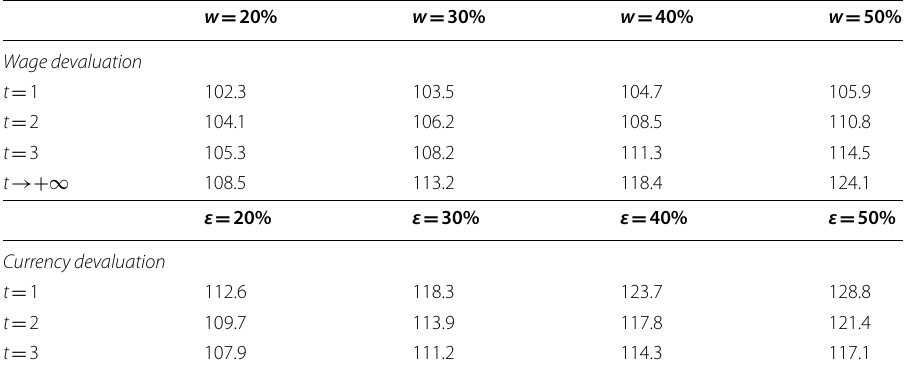
Table 8 The evolution of the international competitiveness (%);